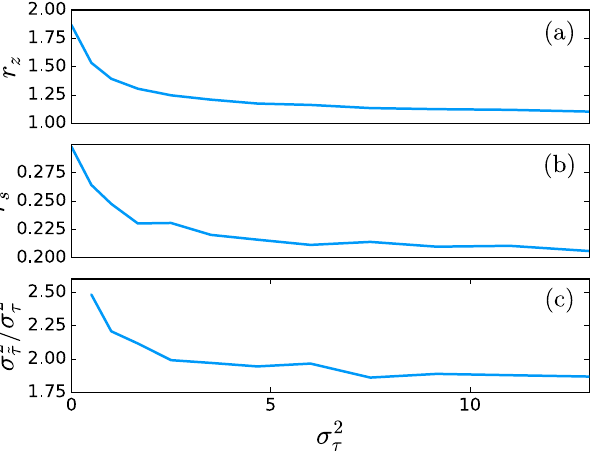
Figure 3. Influence of the variance σ τ 2 of delay distribution. This plot shows the importance of the distribution of the time delay on the results of the algorithm. As the width of the distribution increases, the performance of the optimization get worse. The panels represent in ( a ) the ratio r z = n z /( n − 1), in ( b ) the ratio r s , and ( c ) the 2 after and σ 2 before the optimization. The simulations have ratio between the variance of the time delays σ τ τ  averaged over 60 realizations of a network with n = 400 vertices with mean degree 〈 k 〉 = 4 for each value of σ τ 2